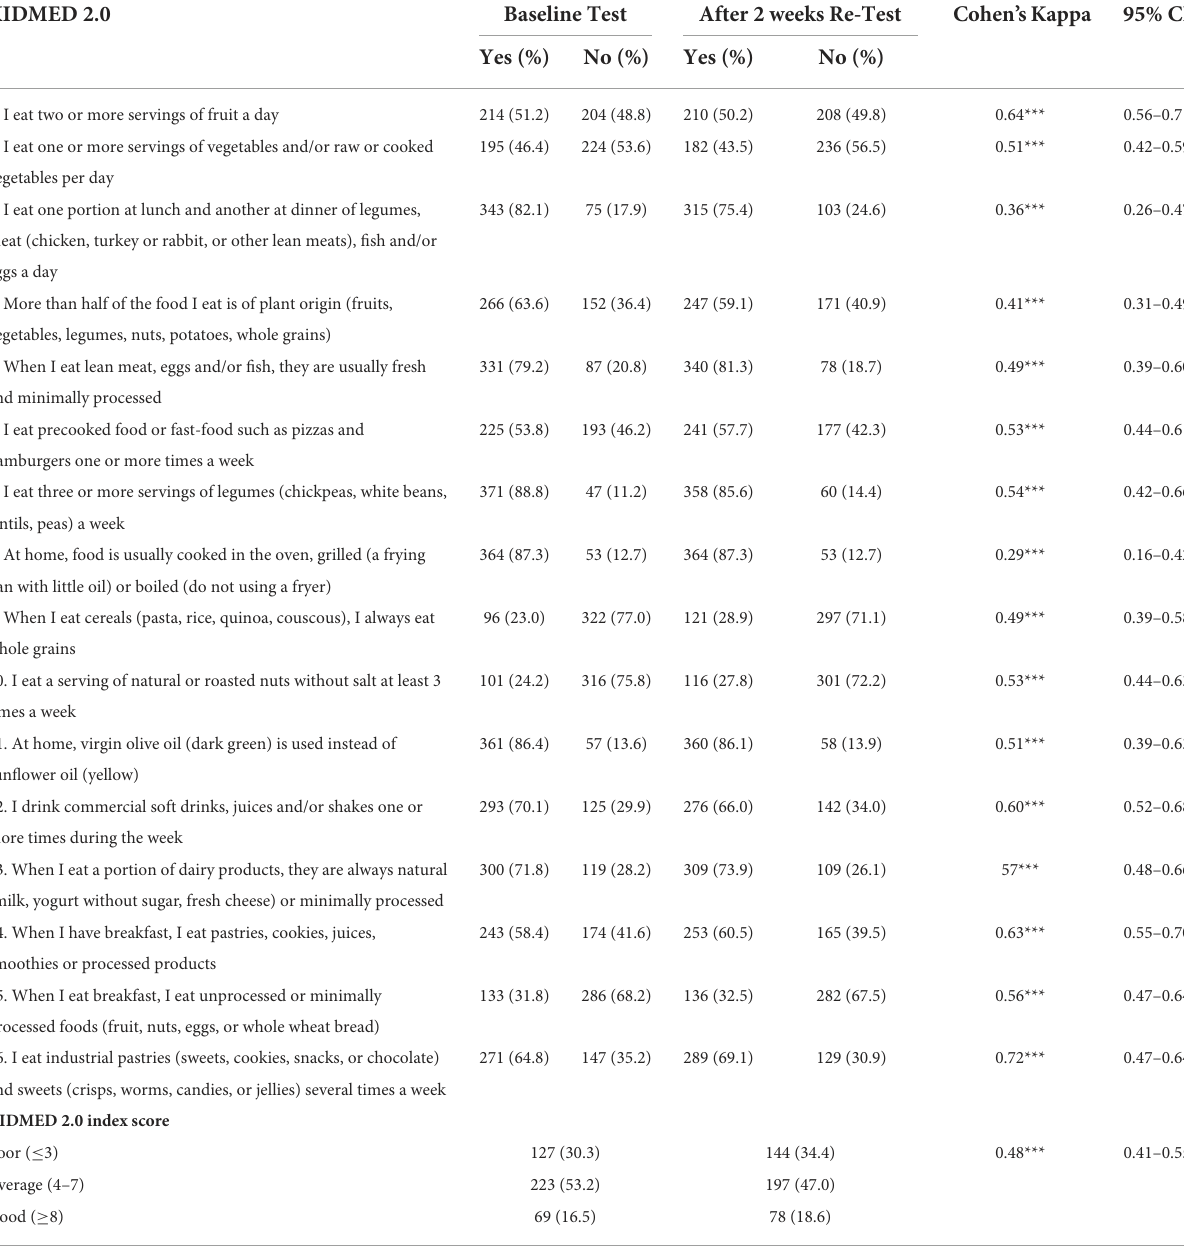
TABLE 1 Test-retest and reliability values of the items of the KIDMED 2.0. KIDMED